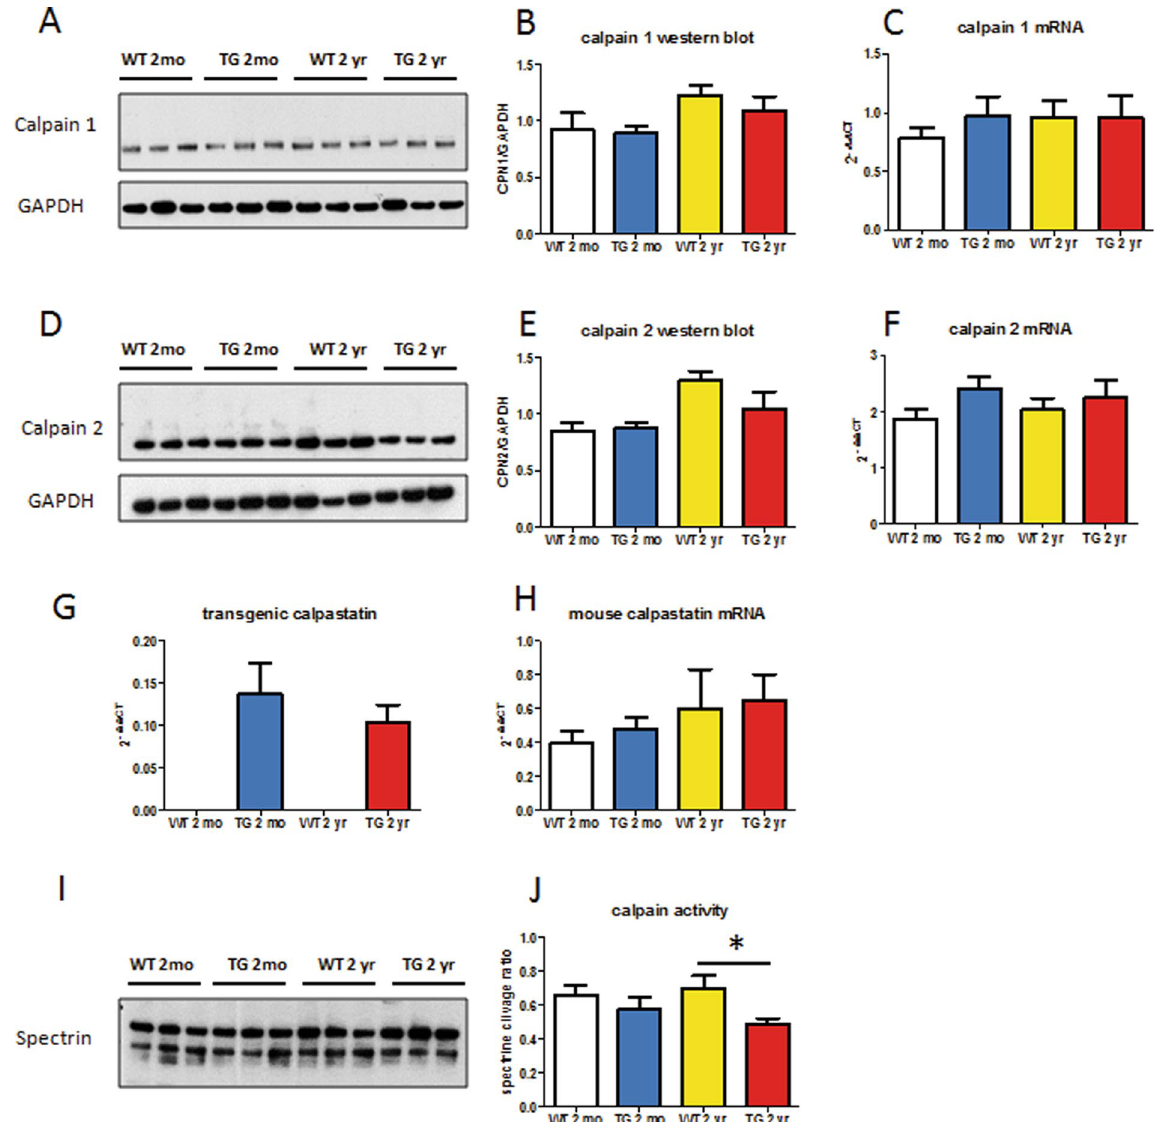
Figure 1. Calpastatin overexpression decreases calpain activity in aged mice. Western blots and quantitative PCR have been performed by using kidney cortex extracts from 2-months old (2mo) and 2 years old (2 yr) wild type (WT) and CalpTG (TG) mice. There was no significant difference of calpain 1 expression in WT and CalpTG mice at 2 months or 2 years at the protein level ( A,B , n = 6/group) or at the RNA level ( C , n = 6/ group). Similarly, calpain 2 expression did not differ significantly between the 2 groups at the protein level ( D,E , n = 6/group) or at the mRNA level ( F , n = 6/group). As expected and previously described, only CalpTG mice expressed the transgenic rabbit calpastatin ( G , n = 6/group). Mouse calpastatin mRNA expression did not differ among the different groups ( H , n = 6/group). Calpain activity was measured by the ratio of the 145 kDa specific breakdown product of spectrin A by calpains, indexed to the intact spectrin. Calpains activity was similar at 2 months but significantly decreased in 2-years old CalpTG mice in comparison to aged WT mice ( I , J , * p < 0.05, n =